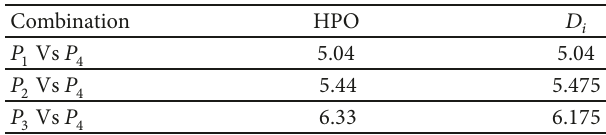
Table 10: Average level of profit for all ML algorithms considered and for each comparison between 𝑃 𝑗 (𝐷 𝑖 ) and 𝑃 4 (𝐷 𝑖 ) across all HPO and 𝐷 𝑖